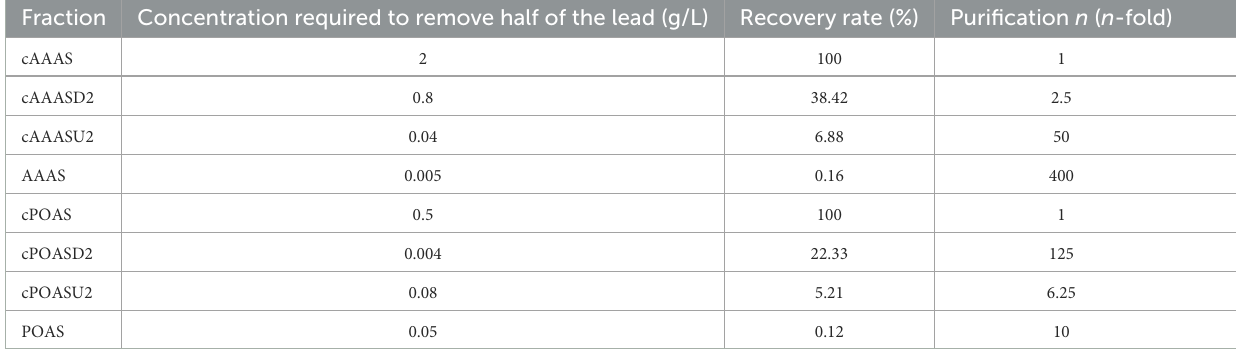
TABLE 2 Efficiency of the active substances from A. auricular and P. ostreatus